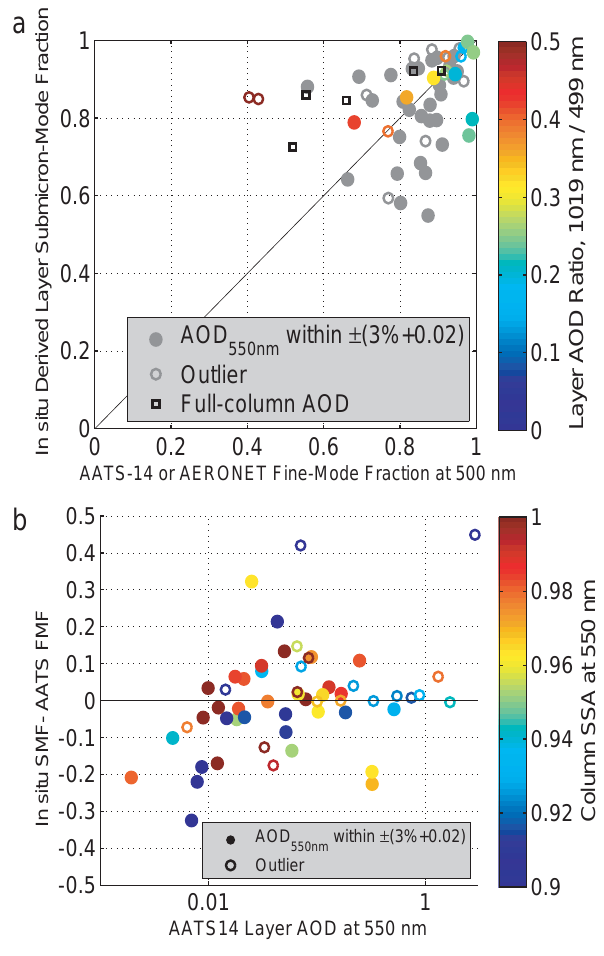
Fig. 8. (a) Fine-mode fraction of AATS-14 (circle) layer AOD and AERONET full-column AOD (black square) individually compared with the submicron-mode fraction of in situ derived layer AOD ad- justed to 500nm (vertical axis). The filled markers indicate the ver- tical profiles that see agreement within 3%+0.02 between the layer AODs. Other profiles are marked with empty circles. The color indicates the 1019/499 AOD ratio, for data with 1019nm AODs greater than 0.04. (b) The difference between SMF and AATS-14 FMF, plotted against the AATS layer AOD interpolated to 550nm. The marker color indicates column-integrated